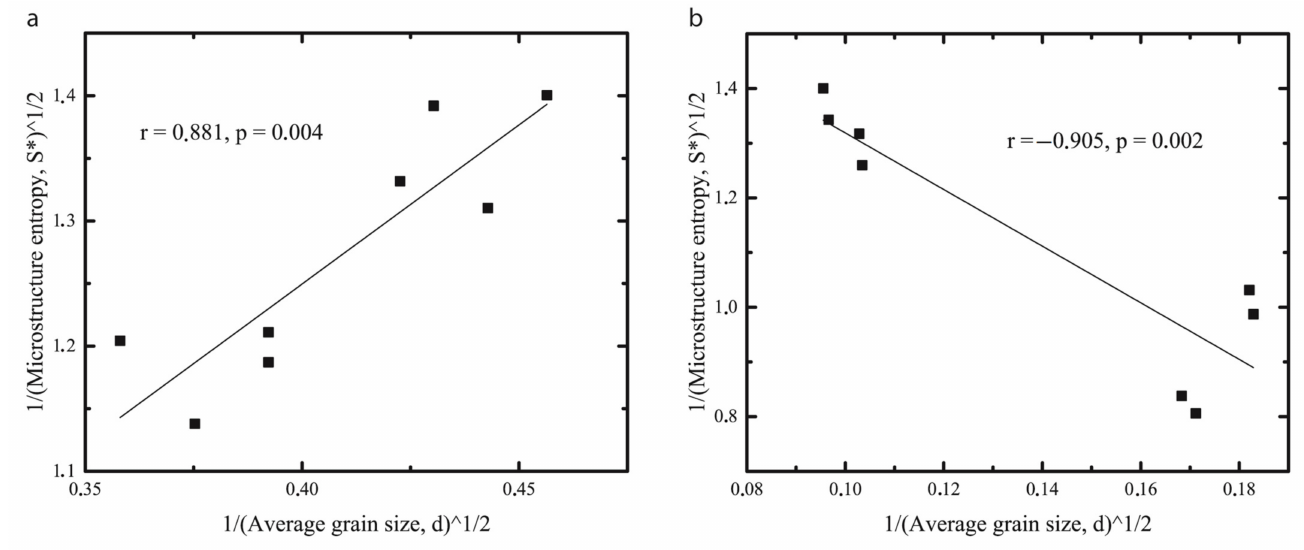
Figure 3. Relationship between microstructure entropy ( S ∗ m ) and average grain size ( d ) for beeswax ( a ) and beeswax hydrocarbons ( b ) based oleogels.